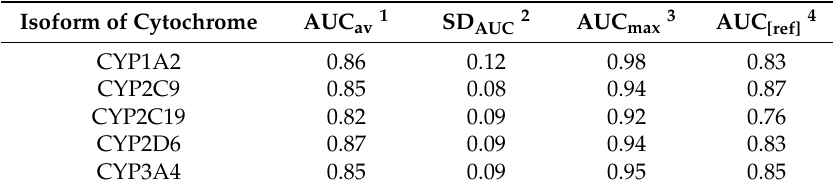
Table 3. Comparison of the performances of the QNA-based approach and the results reported in Rudik et al., 2014. The average and best AUC values in our method were obtained by means of random division into the training and test sets in a proportion of